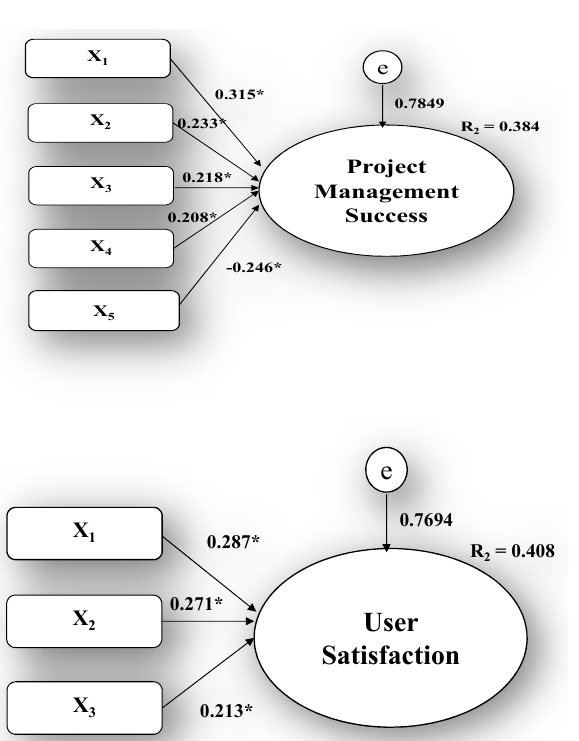
Figure 3. Predicted path model of e-procurement implementation